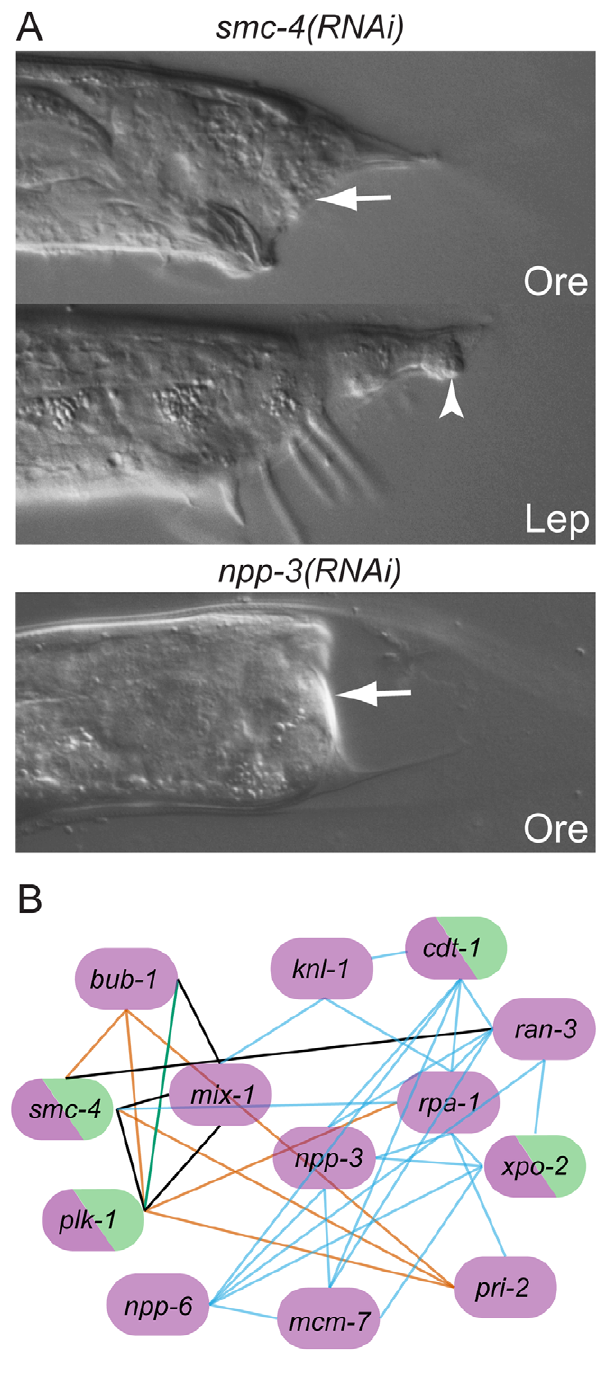
Figure 3. Genes with Ore-like phenotypes. (A) DIC images of male tails: RNAi of smc-4 resulted in Ore (arrow) and Lep (arrowhead) phenotypes. npp-3 RNAi resulted in severe Ore tails (arrow). (B) Subnetwork of genes that produce the Ore phenotype as reconstructed by N-Browse [17]. Thirteen of the 22 genes with an Ore phenotype are tightly clustered: purple, Ore RNAi phenotype; green, Lep RNAi phenotype; black edges: predicted genetic interactions; orange edges: expression correlation; blue edges: phenotypic correlation in the embryo; green edges: protein-protein interaction (multiple data sources, see